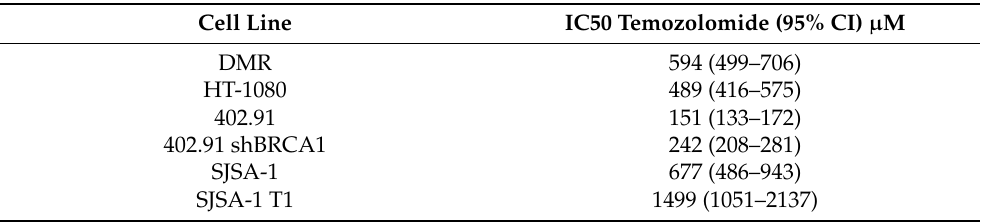
Table 2. IC50 and 95% CI after 72 h-temozolomide treatment. Cell